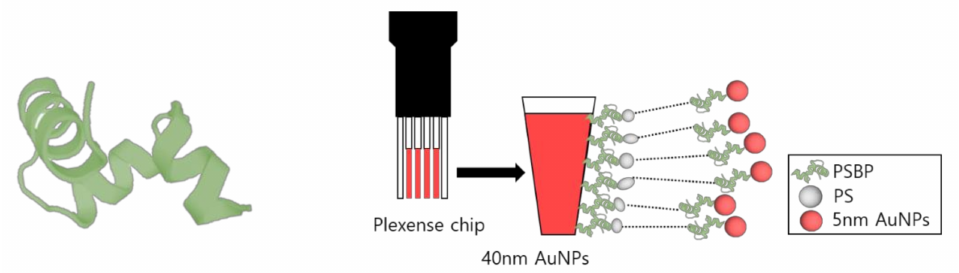
Figure 1. Images of 3D structure of polystyrene-binding peptide (PSBP) and schematic diagram of LSPR sensor chip implemented in sandwich assay